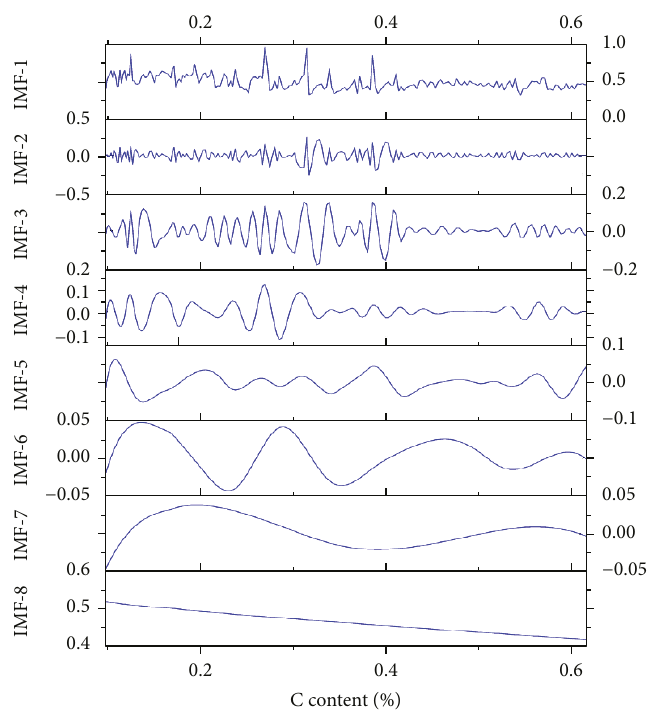
Figure 10: Carbon-IMF frequency diagram of converter 6C00582 signalled with relative